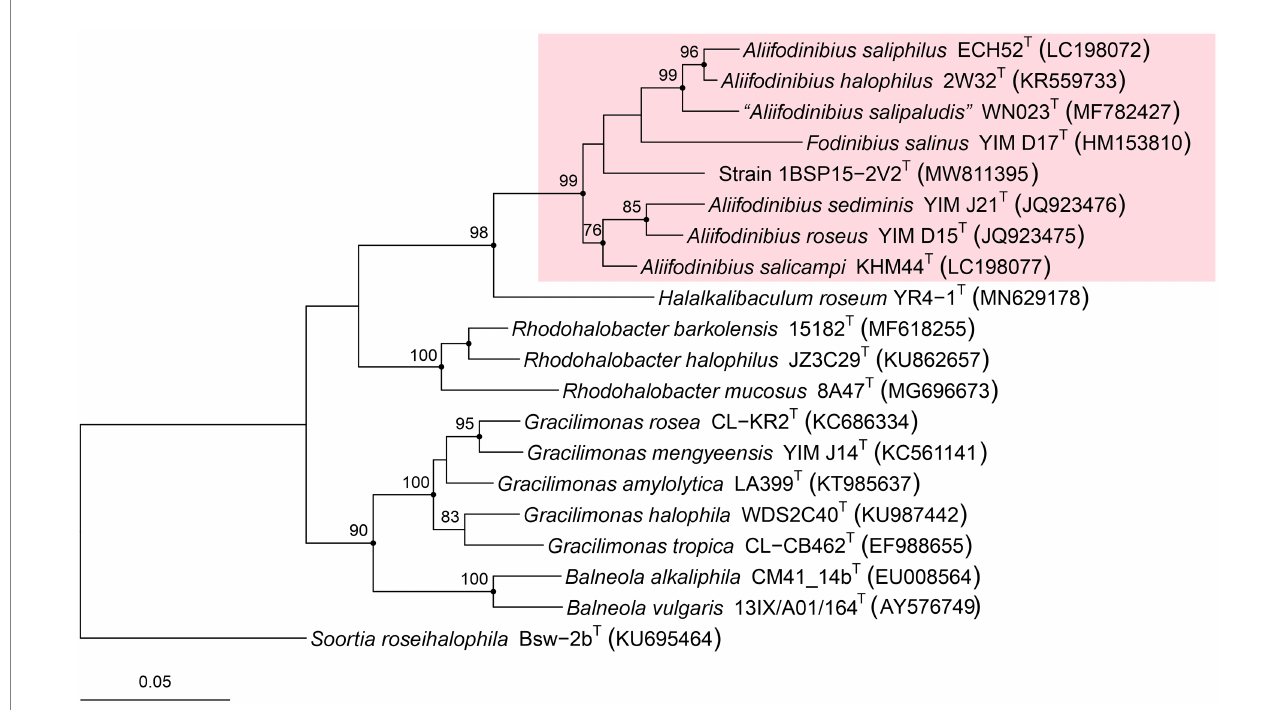
FIGURE 1 Maximum-likelihood phylogenetic tree based on the comparison of the 16S rRNA gene sequences showing the relationships among members of the family Balneolaceae . Bootstrap values equal or higher than 70% based on 1,000 pseudoreplicates are indicated at selected branch nodes. Filled circles indicate that the corresponding node was also obtained in the trees generated with the maximum-parsimony and neighbor-joining algorithms. The species Soortia roseihalophila , the closest relative to the family Balneolaceae , was selected as an outgroup. Bar, 0.05 substitutions per nucleotide